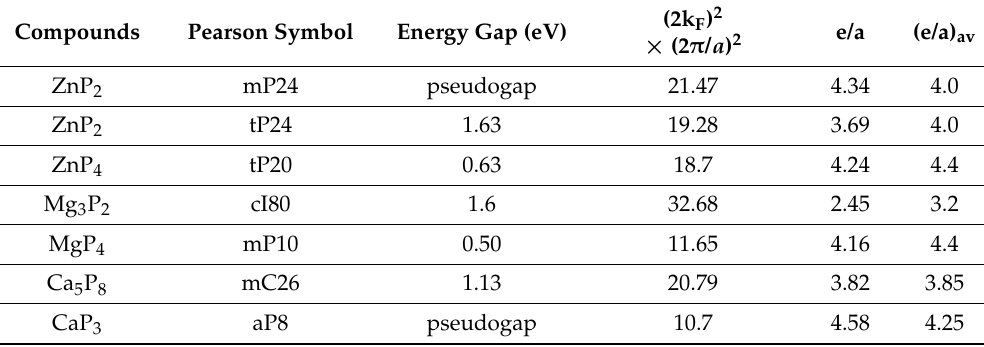
Table 11. P-(non-TM) compounds with e/a = 4.0 ±